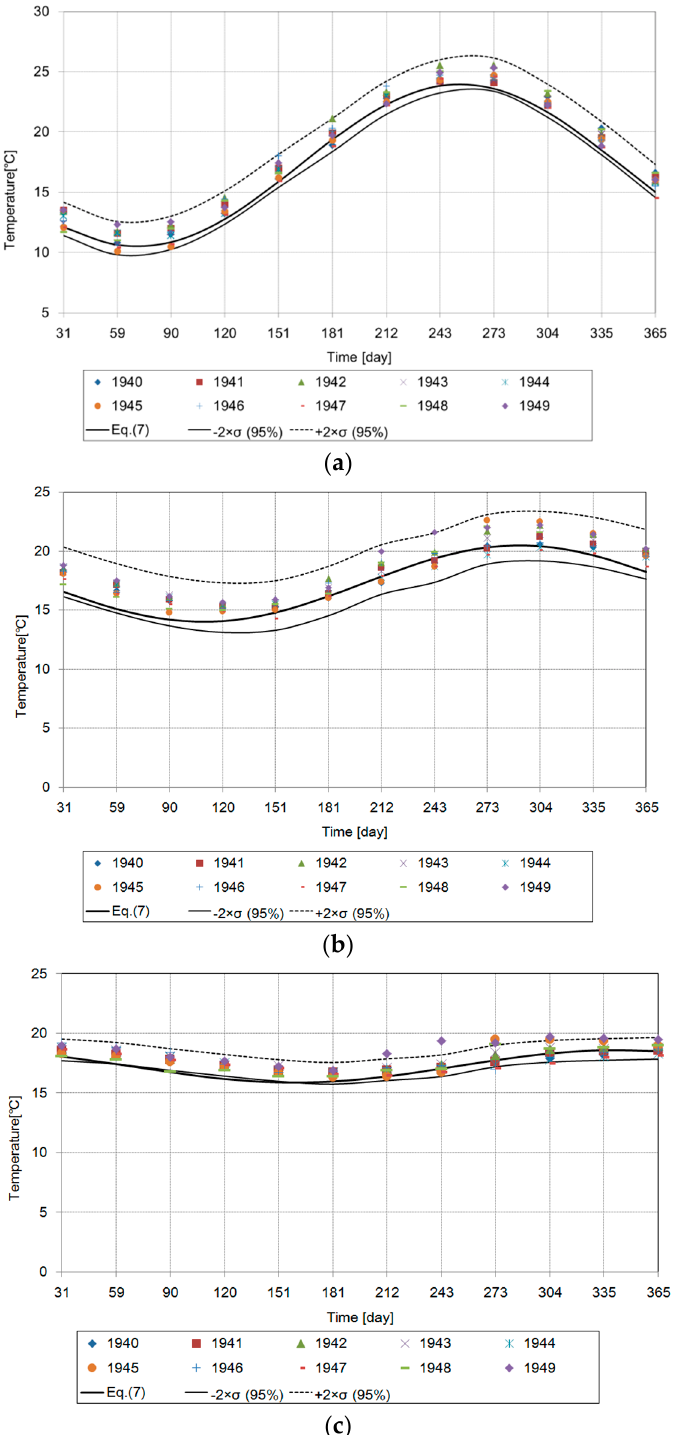
Figure 9. Comparison of experimental and predicted ground temperature distributions in Nagasaki, Japan: ( a ) depth of 1 m; ( b ) depth of 3 m; ( c ) depth of 5 m.